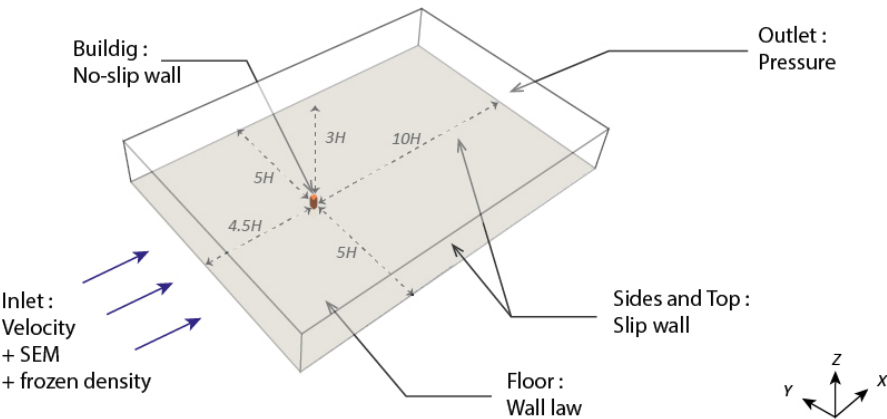
Figure 14. Configuration of the isolated high-rise building case. With δ x = 1.56 × 10 − 3 m and δ t = 1.5 × 10 − 5 s and six refinement levels, the total num- ber of grid points was 5.8 × 10 6 . More details can be found in the work of Buffa et al. [23]. The comparison of mean and standard deviation values of pressure coefficients at the building surface for the different faces of the building and at different heights (Figure 15) shows a very satisfactory match for all the tested data, especially for the mean Cp value. Experimental and simulated data were also extensively compared in terms of spectral analysis and local instantaneous pressure maxima (not shown), showing the reliability of the developed approach for wind load prediction.